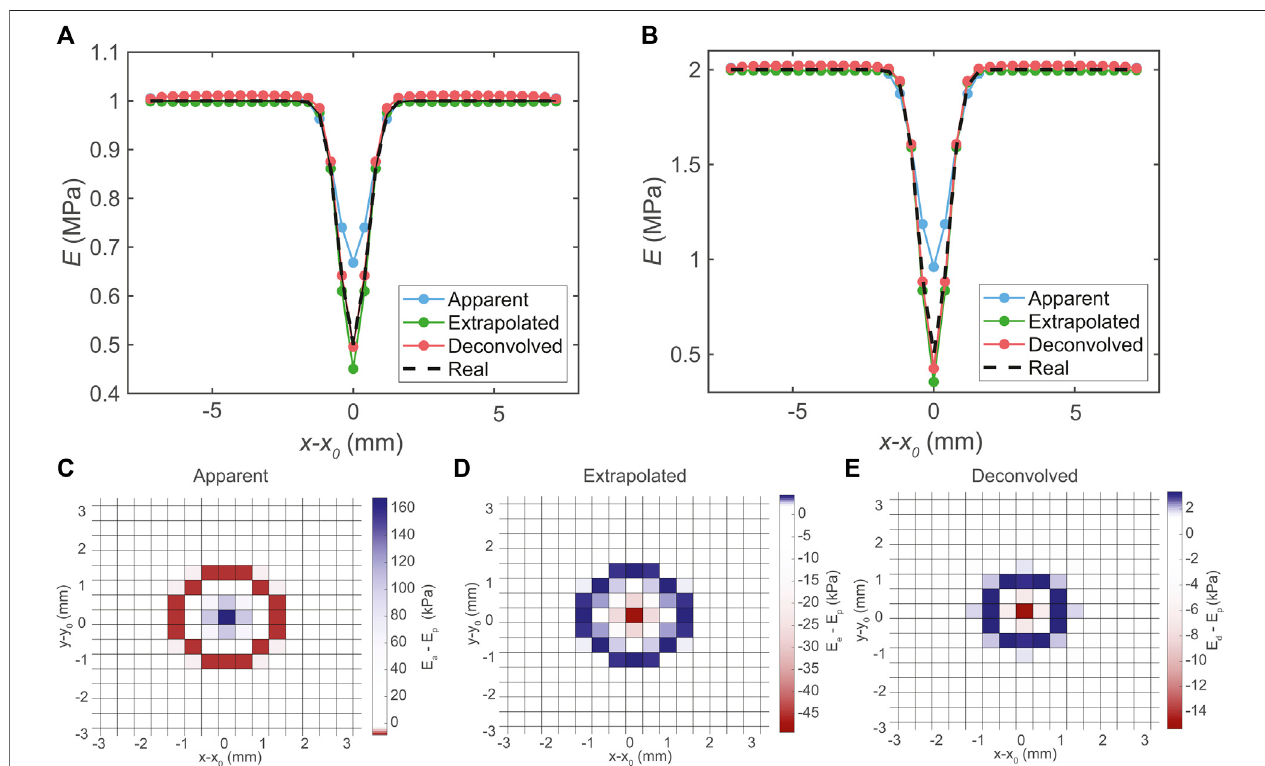
FIGURE 6 | Data of two dimensional modulus pro fi les of a symmetric well, where one quadrant was simulated. (A) All moduli versus probe position plotted as cut line through the center of the well for E 1 (cid:1) 1 MPa and E 2 (cid:1) 0.5 MPa. (B) All moduli versus probe position plotted as cut line through the center of the well for E 1 (cid:1) 2 MPa and E 2 (cid:1) 0.5 MPa. (C) Surfacemapof E a − E , (D) E e − E ,and (E) E d − E forthe E 1 (cid:1) 1 MPaand E 2 (cid:1) 0.5 MPaand w 2 (cid:1) 0.5 mm 2 pro fi le.Extrapolationanddeconvolutionis achieved with L obtained from the 1D stepwise pro fi le (see Figure 4